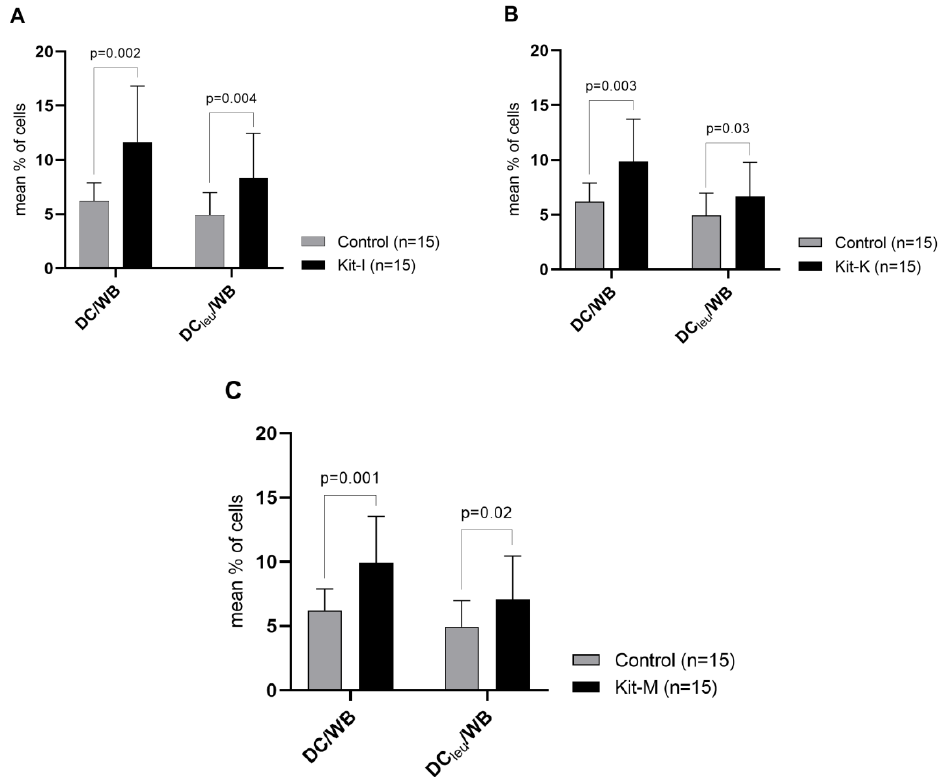
Figure 6. DC/DC leu -generation from leukaemic WB with Kit-I, -K and -M. Given are the mean ± SD of DC/cells and DC leu /cells generated with Kit-I ( A ), Kit-K ( B ), and Kit-M ( C ) compared to control. Statistically significant differences ( p values < 0.05) (two-tailed t-test) are given.